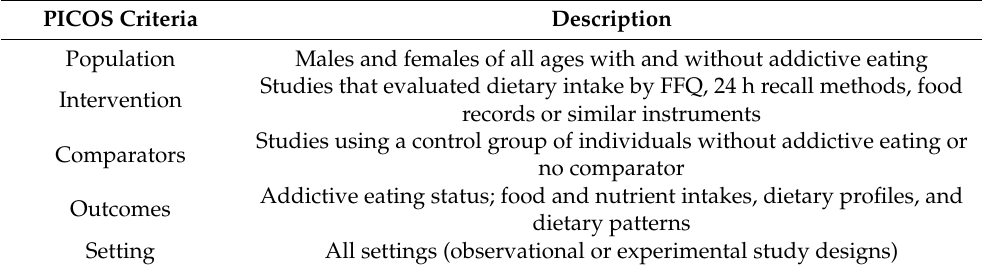
Table 1. PICOS criteria for studies assessing dietary intakes and patterns associated with addictive eating in adolescents and adults. PICOS Criteria Description Population Males and females of all ages with and without addictive eating Studies that evaluated dietary intake by FFQ, 24 h recall methods, food Intervention records or similar instruments Studies using a control group of individuals without addictive eating or Comparators no comparator Addictive eating status; food and nutrient intakes, dietary profiles, and Outcomes dietary patterns